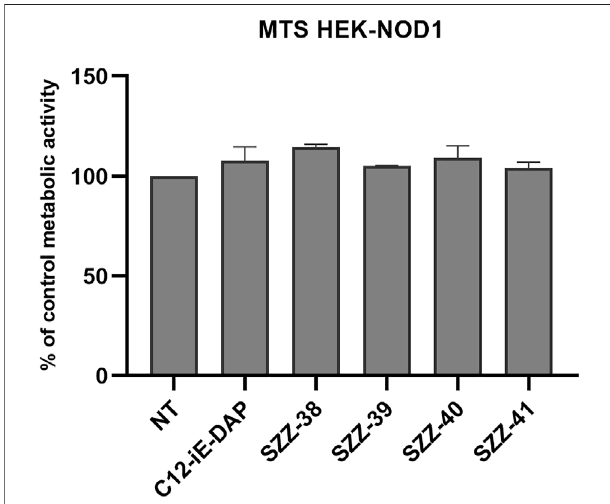
FIGURE2| ProliferationratesofNOD1-speci fi cHEK-Bluecellsfollowing 20 h incubation with C12-iE-DAP (1 µM) and constrained iE-DAP derivatives SZZ-38, SZZ-39, SZZ-40, and SZZ-41 (all at 1 µM). The rates, expressed as meansofduplicates ±SEMoftwoindependent experiments, areshown relative to that of the control (NT).